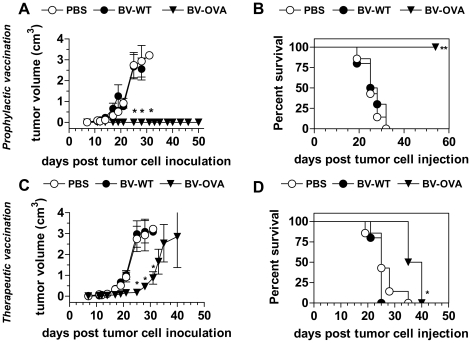
Prophylactic and therapeutic vaccinations with BV-OVA.(A, B) Prophylactic vaccination. Groups of eight C57BL/6 mice were immunized by a single i.v. injection of 5×107 PFU BV-WT, BV-OVA or PBS. Seven days later, immunized mice were challenged with a s.c. injection of 1×105 syngenic OVA-expressing melanoma cells (MO5 cells). (A) Progression of tumor volumes and (B) survival are shown. (C, D) Therapeutic vaccination. Groups of eight C57BL/6 mice were challenged with an s.c. injection of 1×105 MO5 cells. Seven days later, mice showing palpable tumors were treated with 5×107 PFU BV-WT, BV-OVA or PBS by i.v. injection. At days 11 and 17 post-tumor cell inoculation, mice were s.c. injected near to the tumors with 1×107 PFU BV-WT, BV-OVA or PBS respectively. At day 21 post-tumor cell inoculation, mice were intratumorally injected with 1×107 PFU BV-WT, BV-OVA or PBS respectively. (C) Progression of tumor volumes and (D) survival are shown. Results are representative of three independent experiments and are expressed as mean+/− SEM (n = 8). *, p<0.05; **, p<0.01.